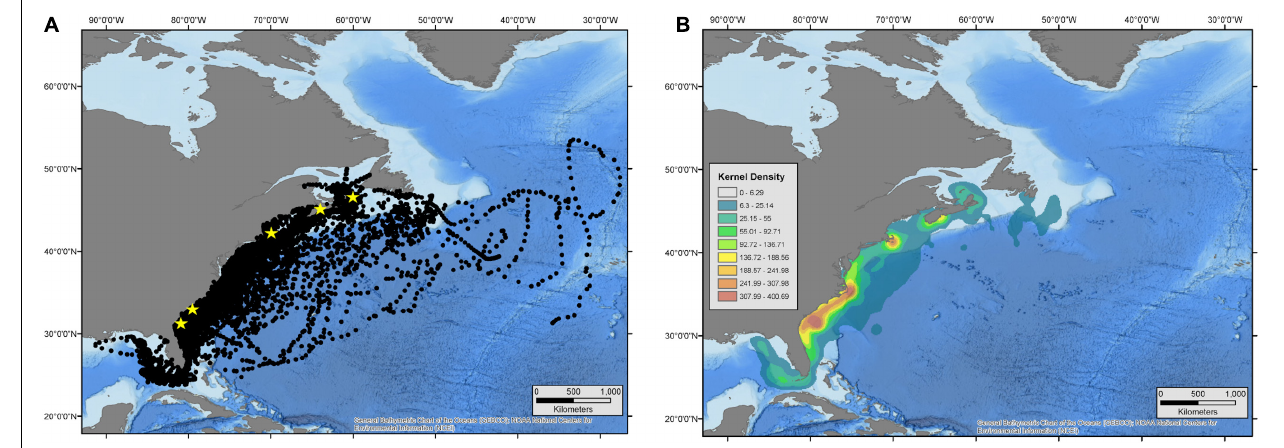
FIGURE 2 | Daily hSSM-derived locations (A) and an overall estimated kernel density (B) for all white sharks tagged between 2012 and 2020. Yellow stars in panel (A) represent general locations of tagging in NE Florida, Georgia/South Carolina, Massachusetts, and two locations in Nova Scotia.